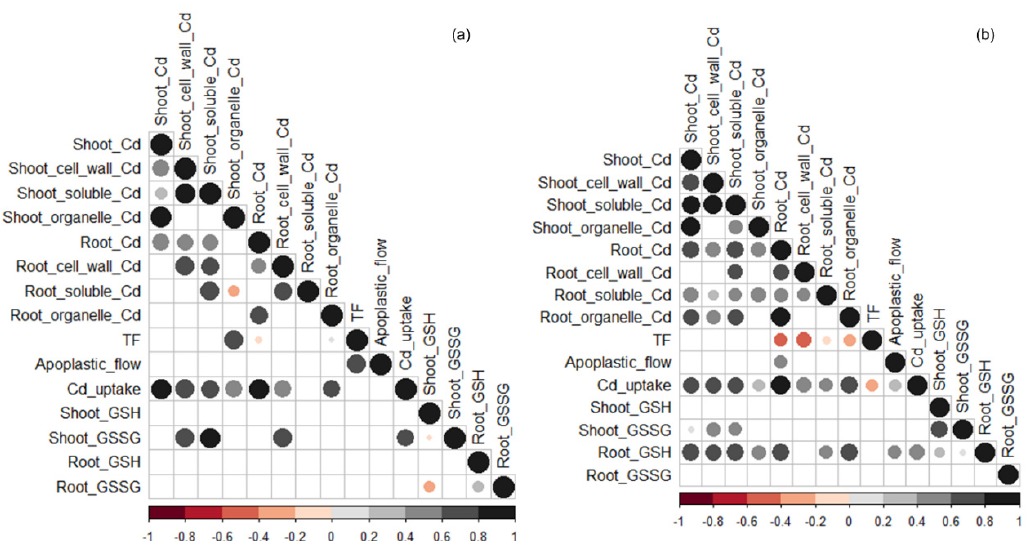
Figure 3. Correlations between Cd concentrations in the shoot and root and their subcellular distributions (i.e., cell wall, soluble, and organelle fractions), translocation factor (TF), apoplastic bypass flow, Cd uptake per unit root length, and concentrations of glutathione (GSH) and glutathione disulfide (GSSH) in shoot and root in Cd-untreated ( a ) and -treated ( b ) plants. The circle size and color darkness indicate the correlation coefficient, and blank cells indicate insignificant correlations ( p > 0.05).